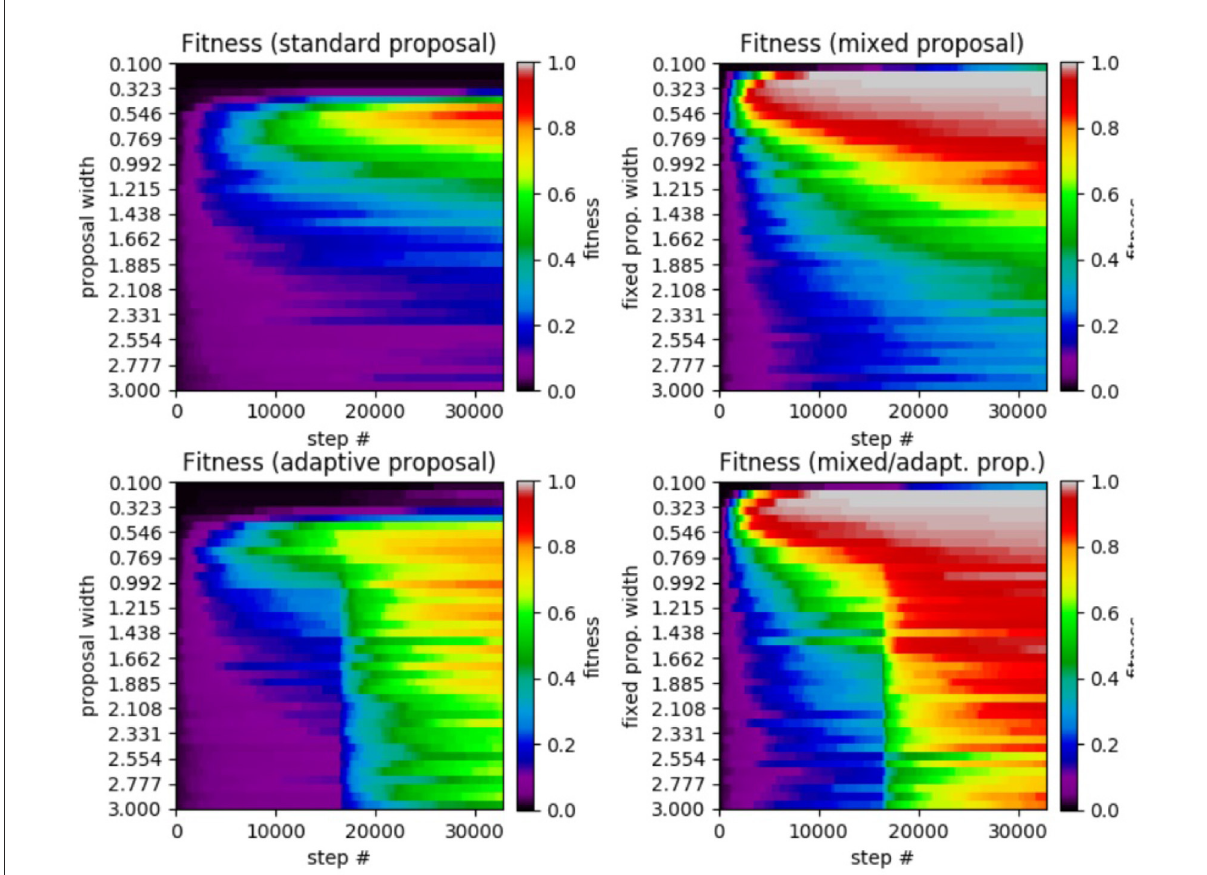
FIGURE2 Results of SA test on the 5D Ackley function. (Top left) Standard SA. (Top right) Mixed SA. (Bottom left) Adaptive SA. (Bottom right) Mixed/adaptive SA. The horizontal axis displays the step number while the vertical axis represents the the proposal width (increases downward). The color axis displays the average fitness across the 50 runs of each